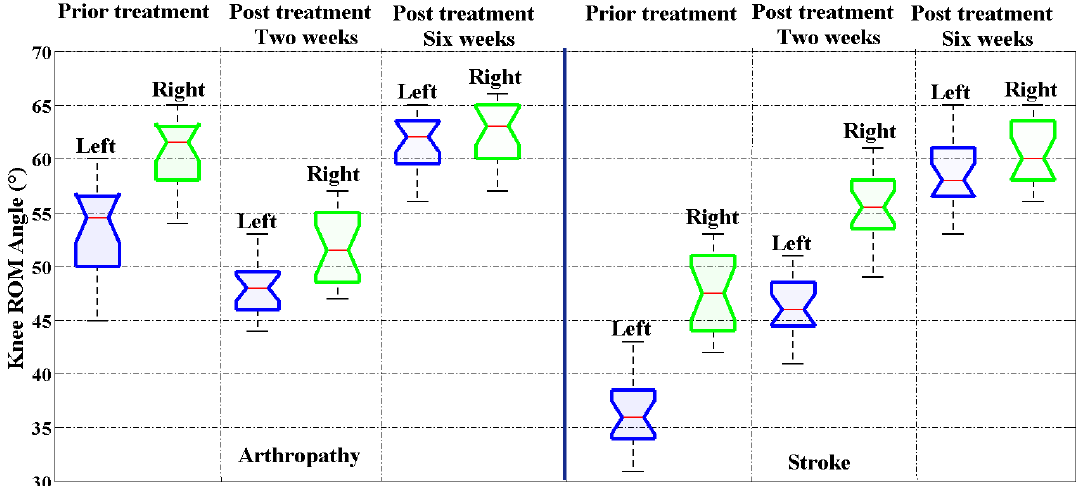
Figure 7. Knee range of motion (ROM) recovery history before and after medical treatments for an arthropathy patient and a stroke patient, respectively. Table 6. Analysis of variance (ANOVA) table of bilateral knee range of motion (ROM) for an arthropathy